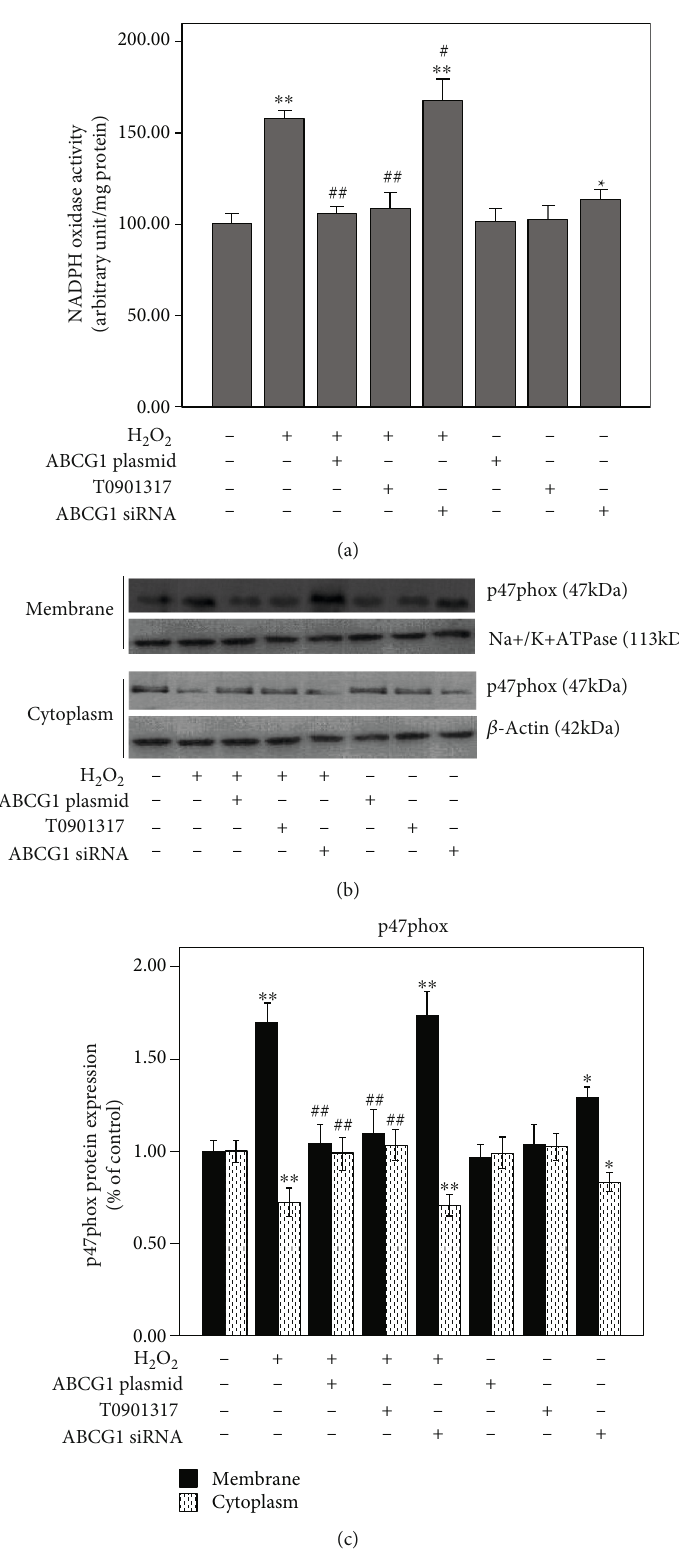
Figure 2: E ff ect of ABCG1 on H O -induced NADPH oxidase activityin HUAECs. HUAECs were transfected with the speci fi c ABCG1 siRNA or 2 2 ABCG1 overexpression plasmid or preincubated with T0901317 and then treated with H oxidase activity was detected by (a) lucigenin-derived chemiluminescence and by translocation of cytosolic p47phox to the membrane via (b, c) western blotting. Data shown are means ± SD ( n = 3 ). ∗ P < 0 : 05 , ∗∗ P < 0 : 001 vs. normal controls; ## P < 0 : 001 vs. HUAECs treated with H